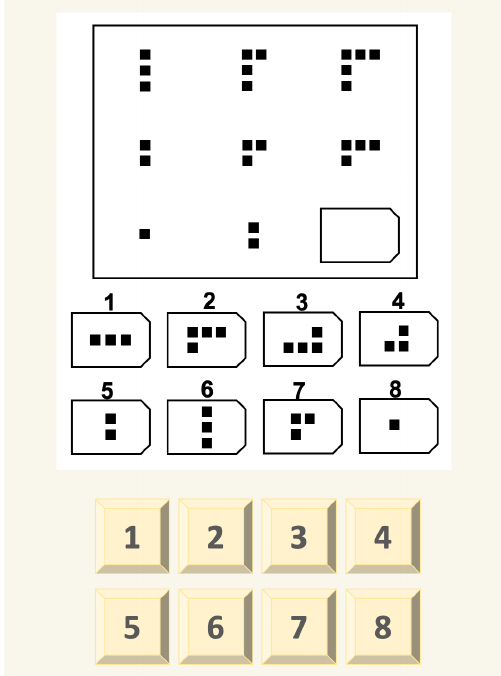
Figure 1. Users’ interface for individual task. Users’ interface of the Raven’s Advanced Progressive Matrices test (RAPM) that participants faced individually. The buttons at the bottom of the interface correspond to the eight answer options for the matrix